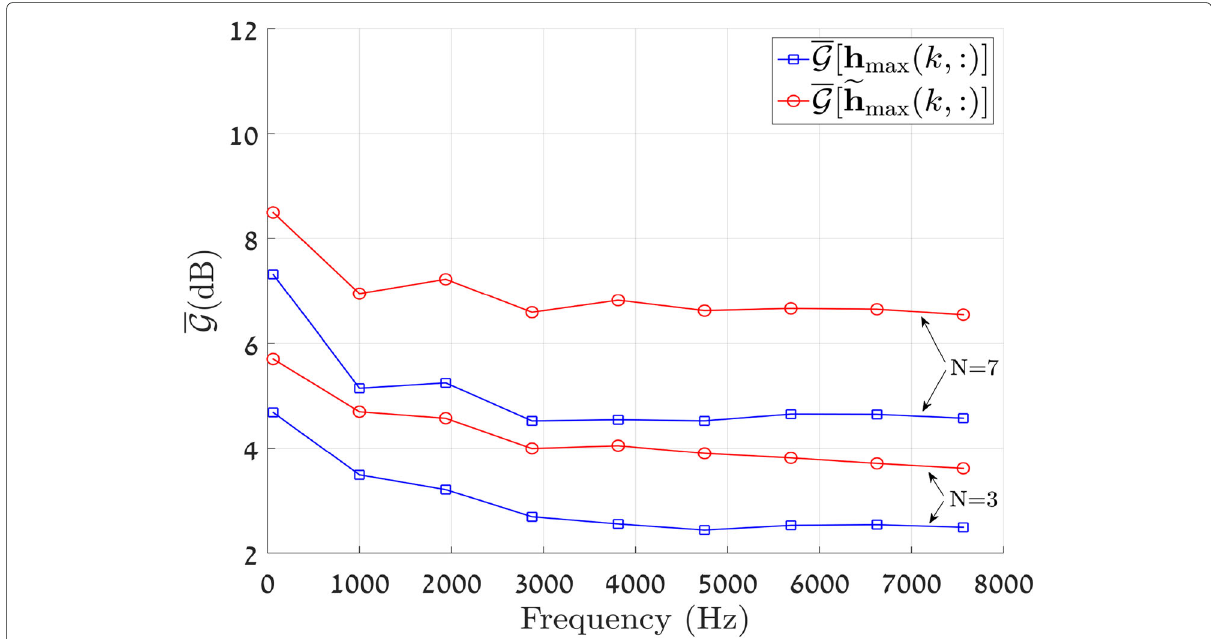
Fig. 4 Average subband SNR gains of TIMIT speech signals for iSNR = 0 dB and for N = 3 and N = 7, with white Gaussian noise. We set τ y = 2 for the quadratic filter (cid:6) h max ( k , n